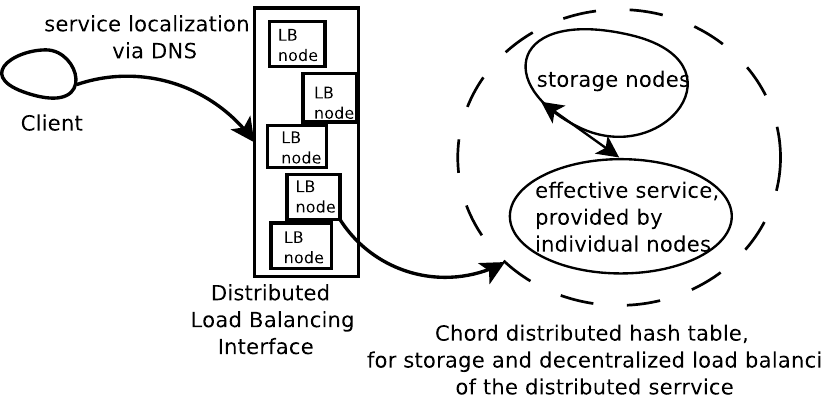
Figure 4. Generic method for distributing and decentralizing a service, in order to make it highly